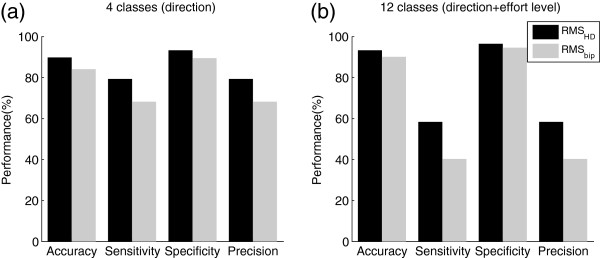
Classification performance using the feature RMSav-HD (in black) extracted from HD-EMG maps or RMSav-bip (in gray) extracted from single bipolar EMG signals. a) Four classes corresponding to type of task (flexion, extension, pronation and supination) or b) Twelve classes corresponding to type of task and effort level (10%, 30% or 50% MVC).